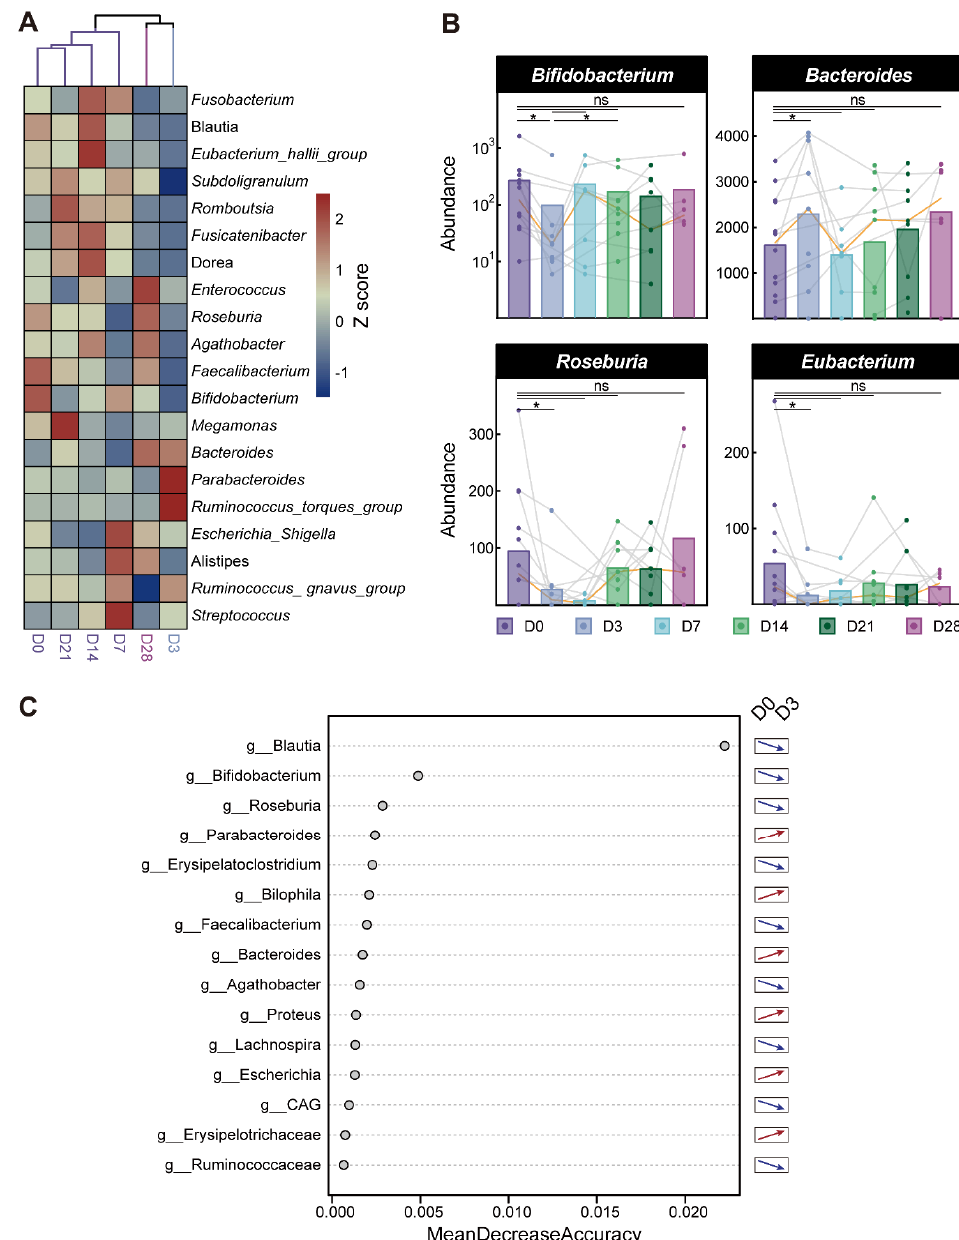
Figure 5. The specific microbiota changed with time after bowel preparation. ( A ) Heatmap showing clustering of intestinal microbiota at the genus level. ( B ) The change trend of four kinds of key bacteria over time was obtained using statistics. Each gray line represents one of the participants and the orange line represents the change in the median. Significance was measured using the Wilcoxon paired signed-rank test. ( C ) Random forest predicted the change trend of genus level microbiota in the early stage after bowel preparation. The out-of-bug (OOB) estimate of error rate is 12.5%. p > 0.05, ns (not significant, may not be indicated); * p <